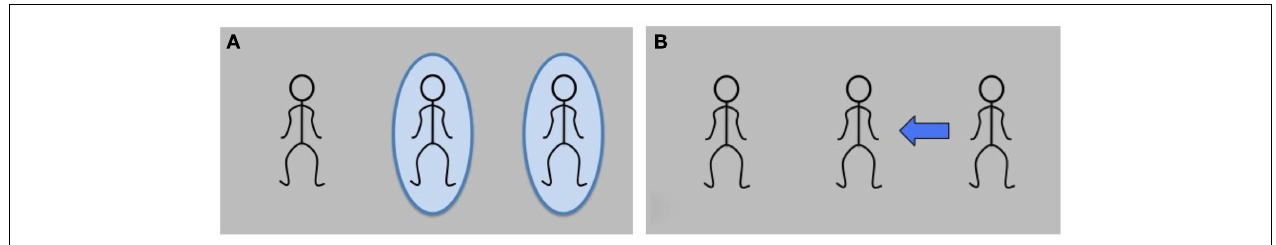
FIGURE 1 |Verification templates. (A) Experiment 1, referent verification:Were the circled characters mentioned in the sentence? (B) Experiment 2, thematic role relations verification: Does the arrow reflect the thematic role relations of the sentence?